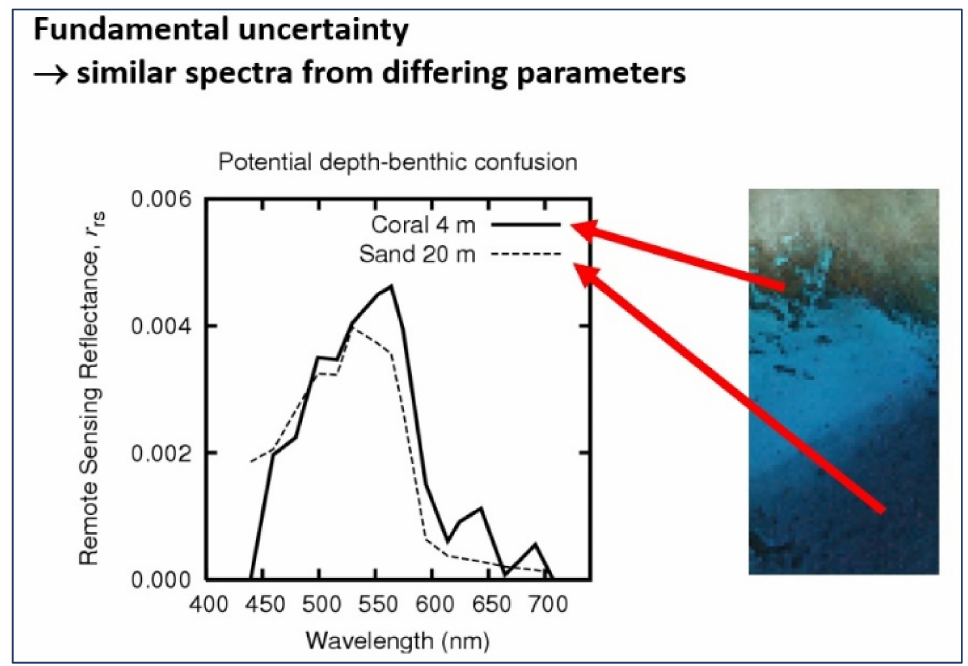
Figure 4. Lyzenga and Lee et al. fundamental problem: one pixel, several possible